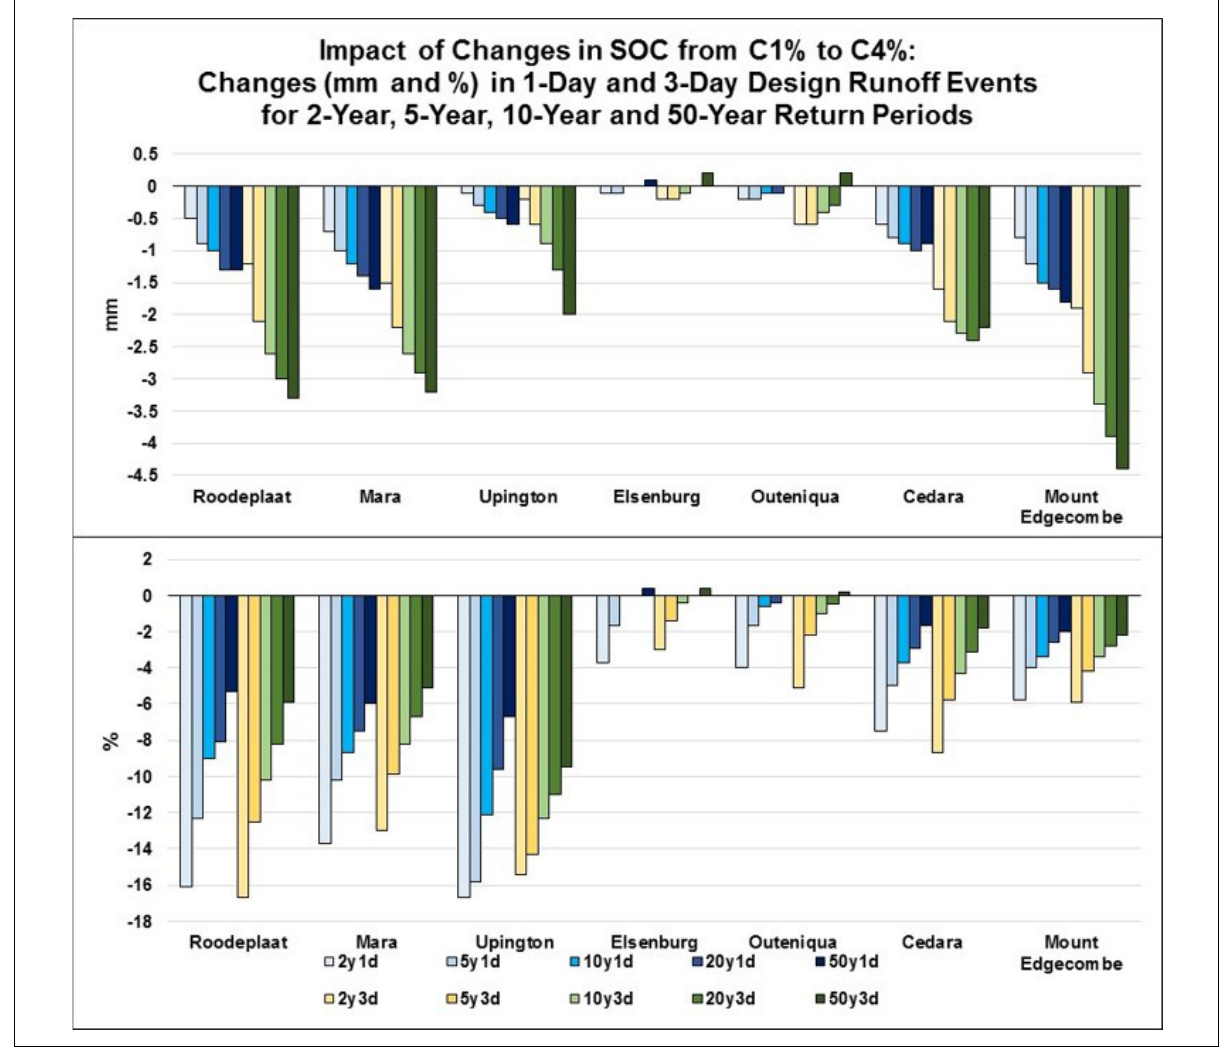
Figure 7: Changes in 1-day and 3-day design runoff events for return periods of 2, 5, 10, 20 and 50 years, with absolute changes (mm, top graph) and percentage changes (bottom graph) shown for selected areas in South